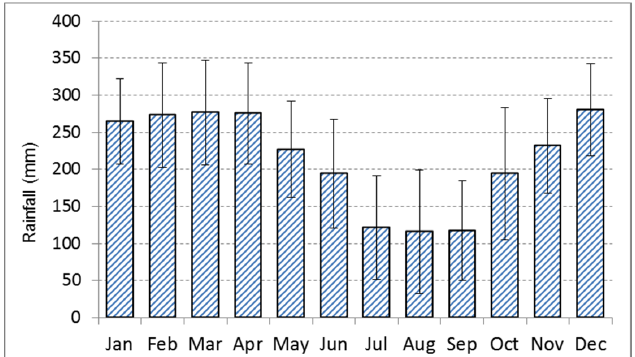
Figure 2. Mean monthly rainfall and standard deviation (mm) at Sampit, Central Kalimantan, Indonesia for 1901–2014 [22]. The climate data is a 0.5 degree resolution data grid for the years 1901 to 2009 produced by the Climate Research Unit of University of East Anglia, UK, and available online http://www.cru.uea.ac.uk/cru/data/hrg/cru_ts_3.23/cruts.1506241137.v3.23/).